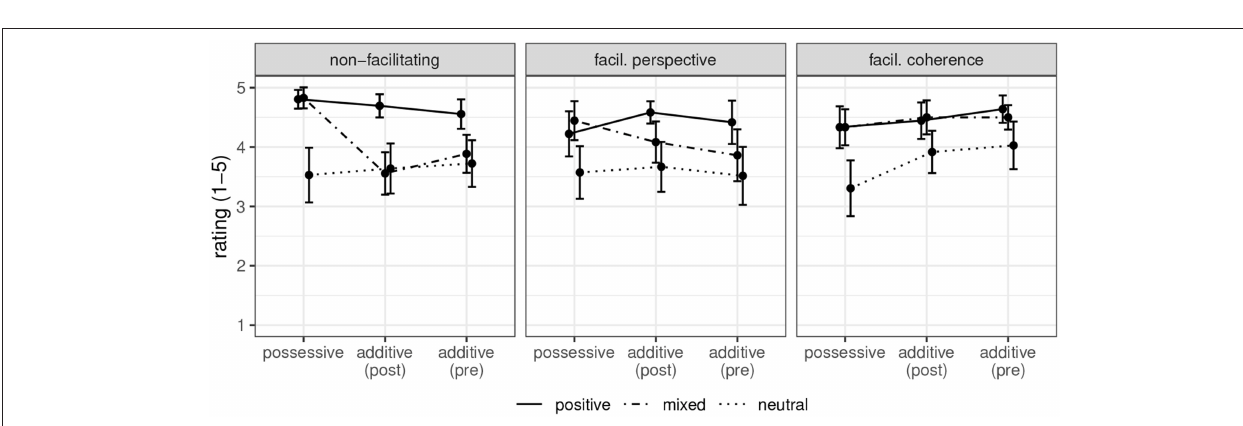
FIGURE 7 | Felicity rating results of Experiment 2 with 95% confidence intervals, split by discourse type.